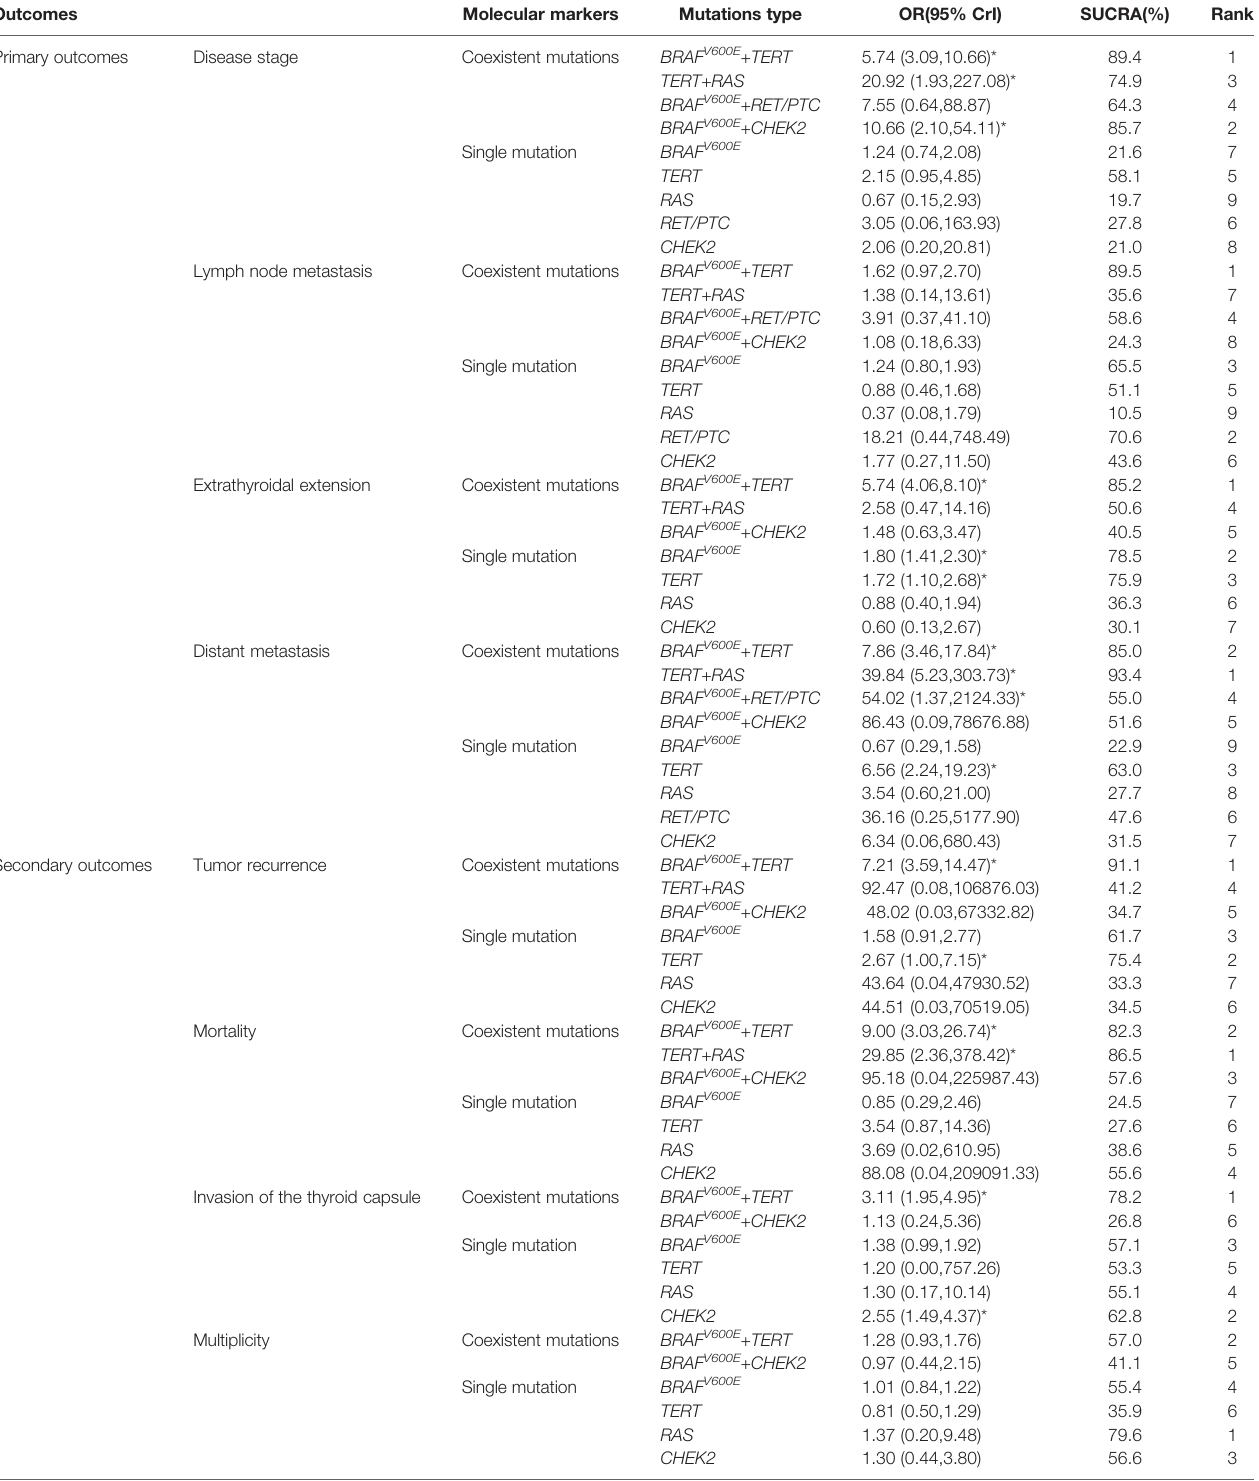
TABLE 2 | Network meta-analysis results for the outcomes in thyroid carcinoma.